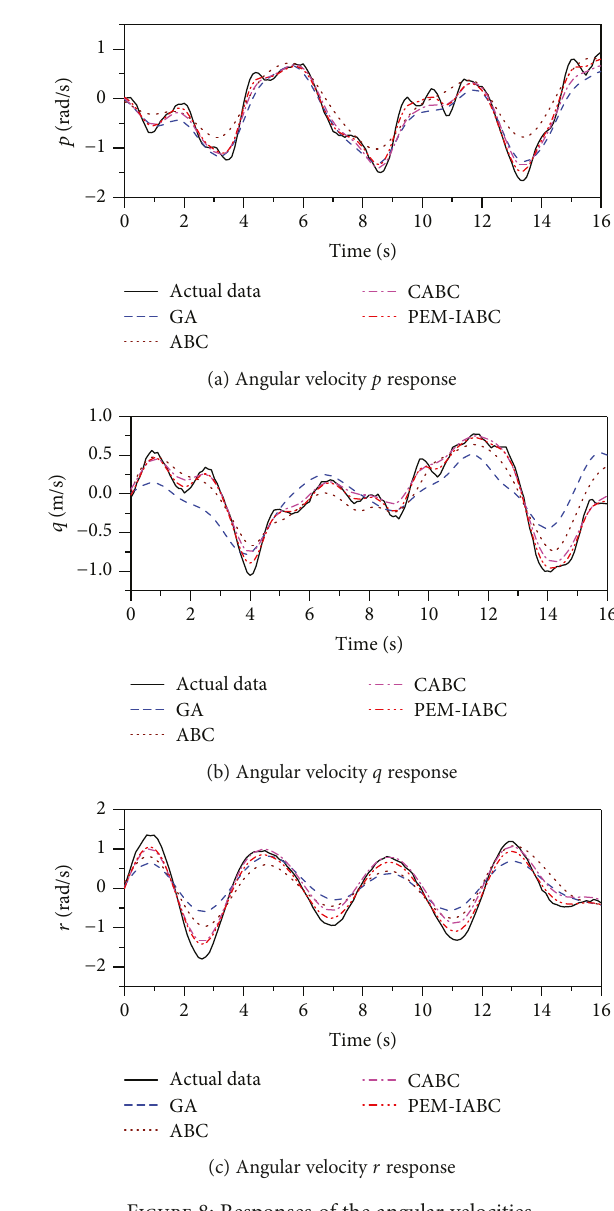
Figure 7: Responses of the linear velocities. Figure 8: Responses of the angular